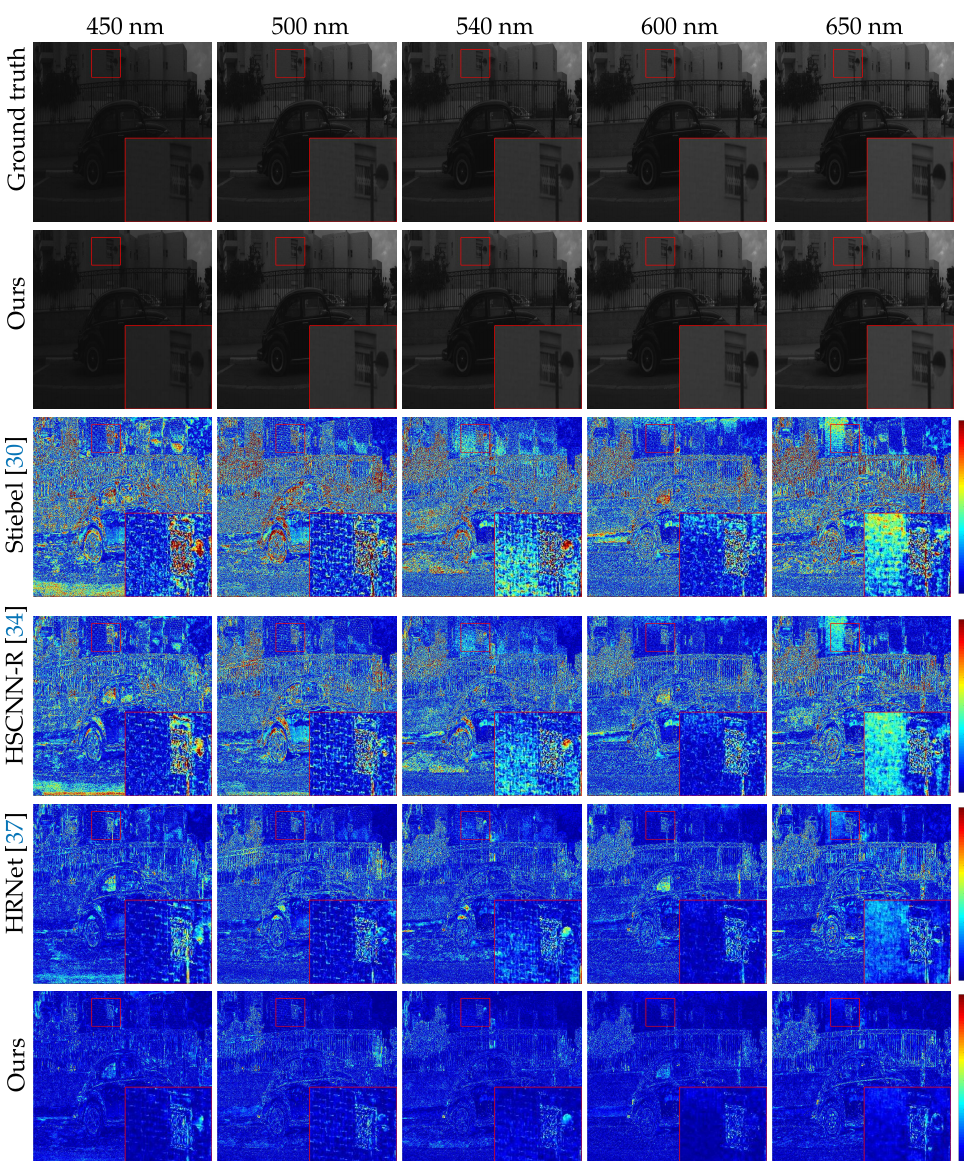
Figure 8. Visual comparison of the five selected bands on “BGU_HS_00259” image from the final testing set of NTIRE2018 “Real World” track. The best view on the screen.